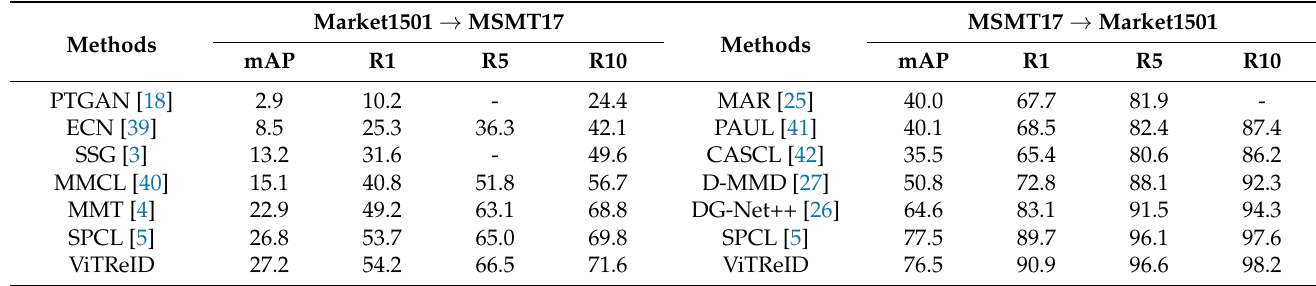
Table 2. Performance comparison between adaptive methods with unsupervised domain.